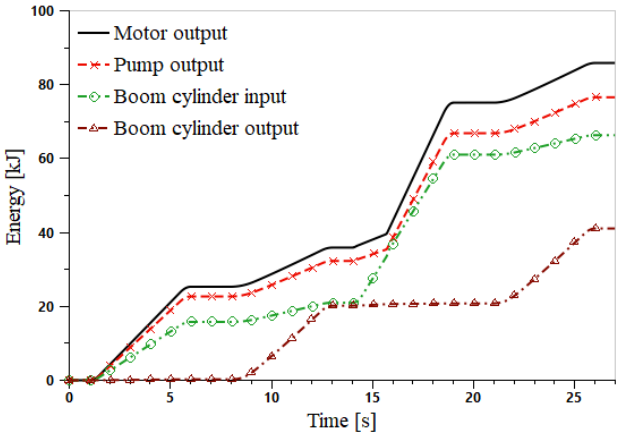
Figure 20. Energy consumption of the proposed system with a fully loaded bucket.